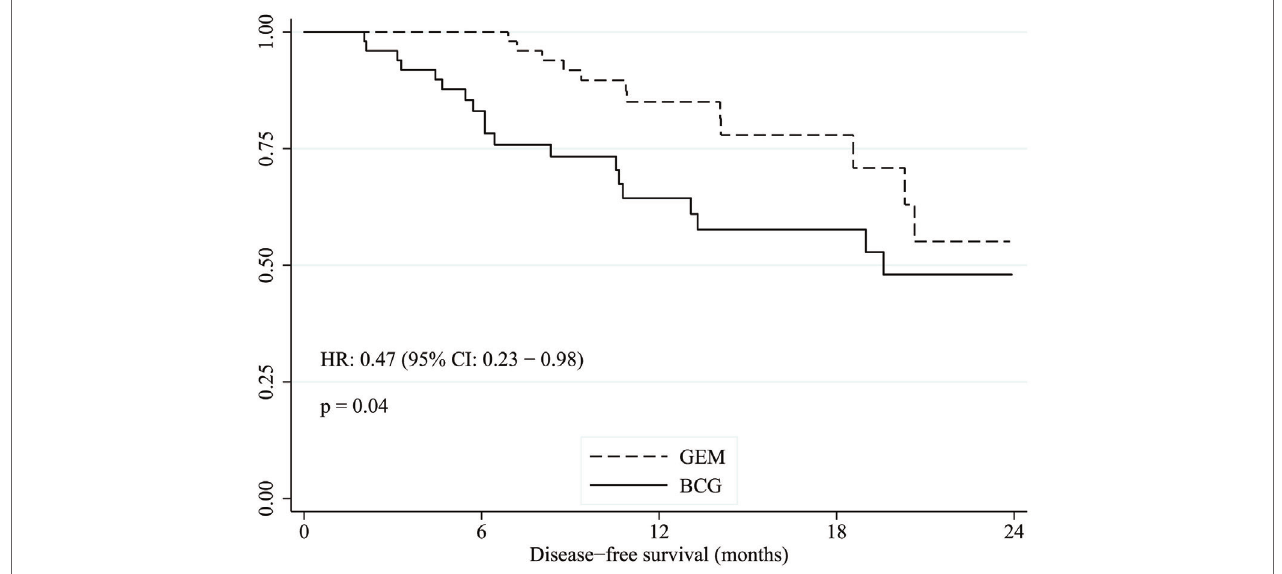
FigUre 1 | Kaplan–Meier estimate of disease-free survival time with gemcitabine versus BCG. GEM, intravesical gemcitabine; BCG, intravesical bacillus Calmette–